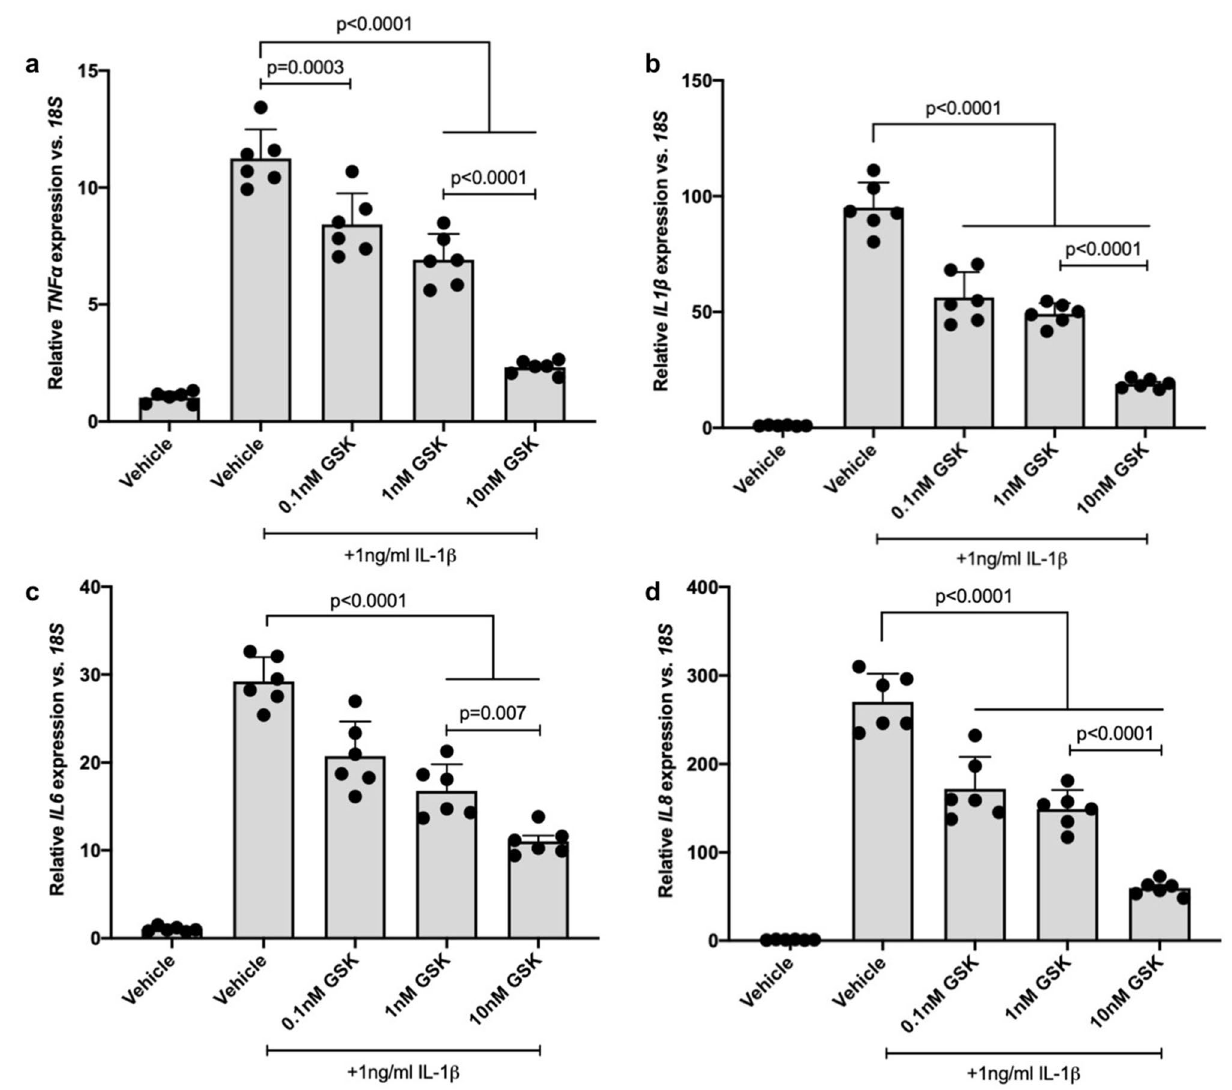
Figure 5. The effect of sEH inhibitor GSK2256294 on IL-1β-induced inflammatory mediator expression by Müller cells. Human Müller cells were treated with IL-1β (1.0 ng/ml) or IL-1β plus 0.1 nM, 1.0 nM, or 10 nM GSK2256294 (sEH inhibitor) for 8 h. Total RNA was isolated and cytokine expression was assayed by qRT- PCR. ( a ) TNFα, ( b ) IL1β , ( c ) IL6 , and ( d ) IL8 expression was significantly decreased at each sEH inhibitor concentration tested. Bars represent mean ± SD (n =